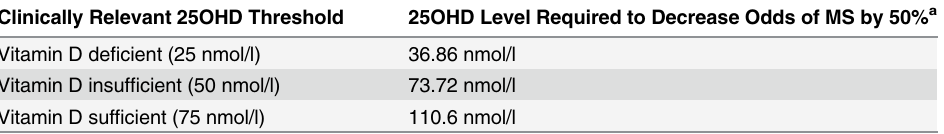
Table 5. Clinical equivalence of a 1-SD natural-log increase in 25OHD for various vitamin D thresholds. Clinically Relevant 25OHD